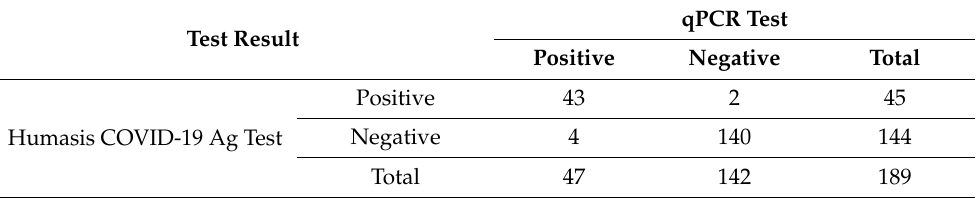
Table 1. Summary of the results obtained by the qPCR method and the Humasis COVID-19 Ag Test.